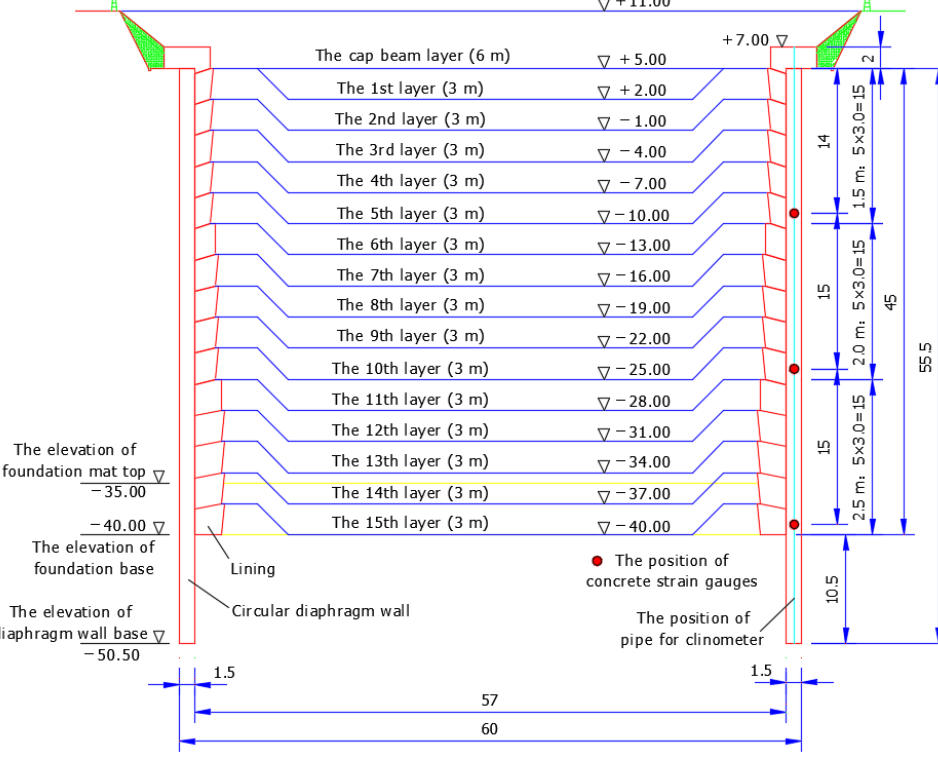
Figure 2. Layered excavation schematic diagram of the foundation pit (the unit is “m”).